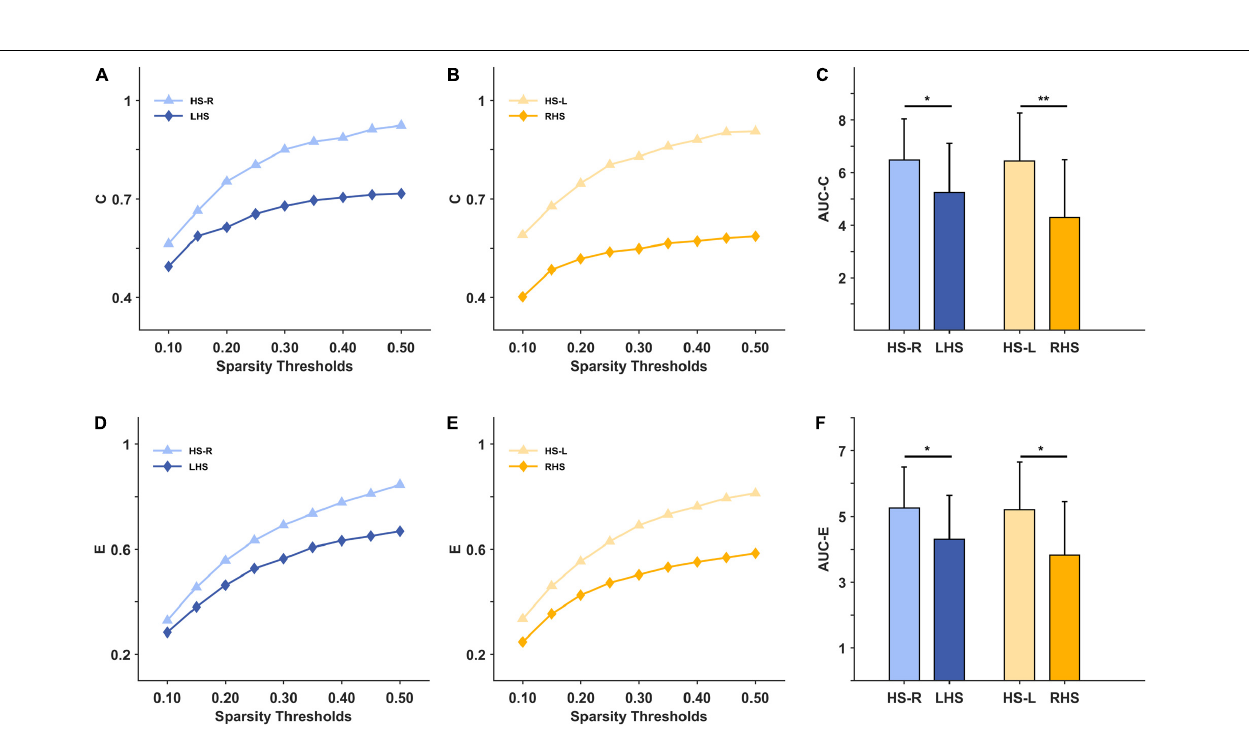
Frontiers in Aging Neuroscience |